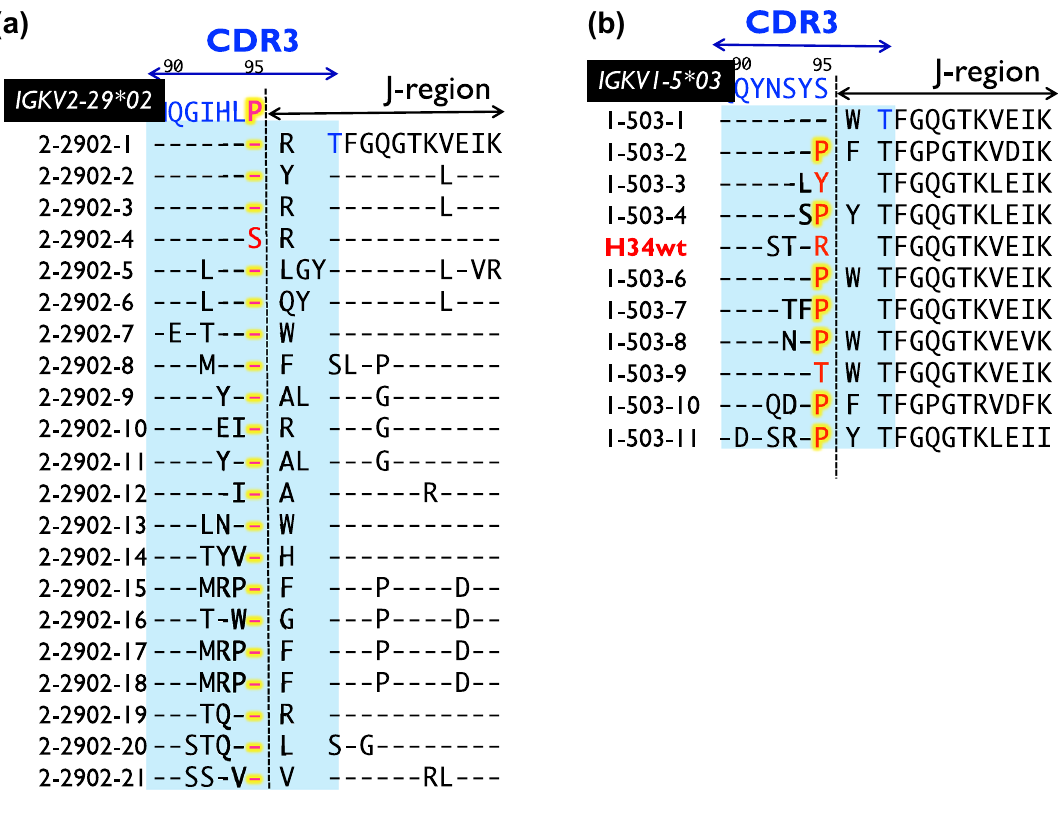
Figure 1. Comparison of amino acid sequences of CDR-3 among germline genes. ( a ) IGKV2-29*02 : the amino acid sequences of germline gene IGKV2-29*02 and 21 human light chain clones. 20 out of 21 clones possess Pro95 residue at the 95th position, indicating that Pro95 is highly conserved. ( b ) IGKV1-5*03 : IGKV1 -5*03 does not contain Pro95; a Ser residue is placed at this position. Although the residue is replaced by somatic mutation, the Ser is replaced with Pro in 64% of the clones (seven out of eleven clones). Antibody light chains tend to contain Pro at the 95th position in